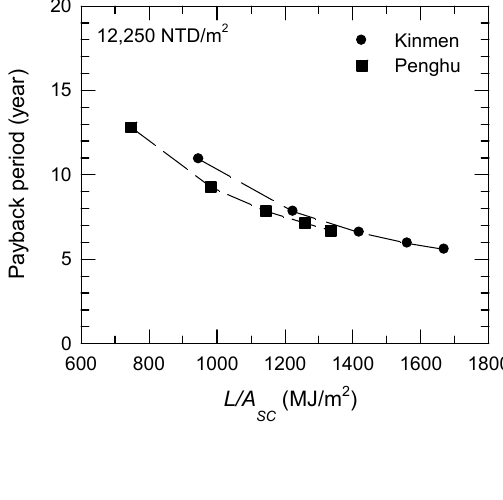
, IC = 12,250 NTD/m 2 sc o